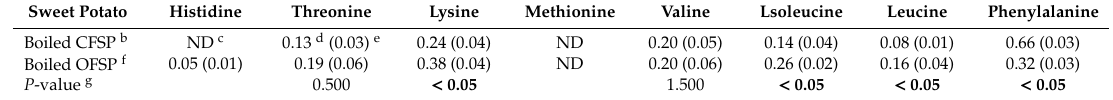
Table 5. Essential amino acid composition of sweet potato (g / 100 g, DW a